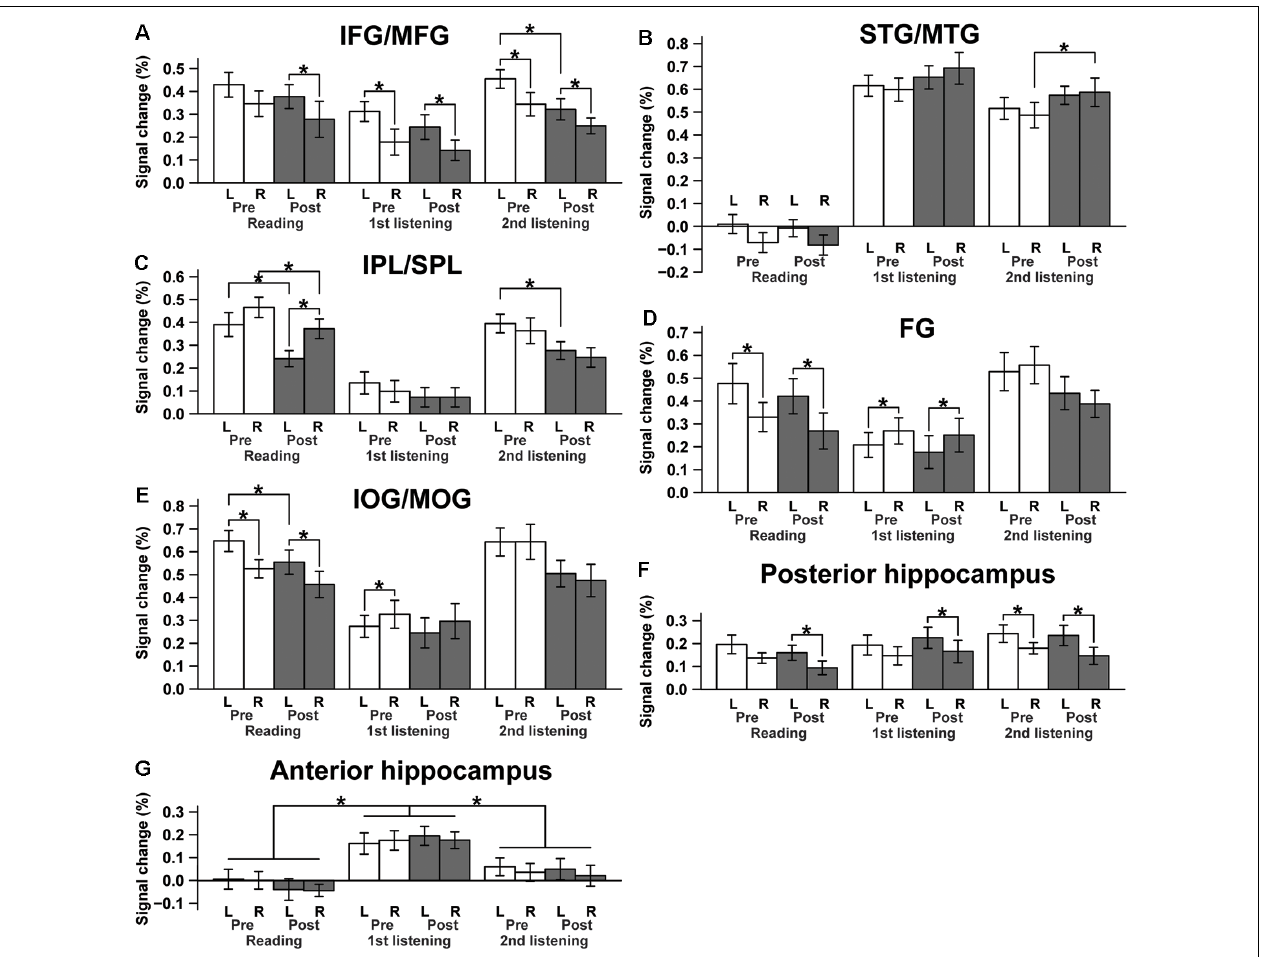
FIGURE 5 | Lateralization and changes in activations from Pre to Post for each ROI. (A) The IFG/MFG, (B) the STG/MTG, (C) the IPL/SPL, (D) the FG, (E) the IOG/MOG, (F) the posterior hippocampus, and (G) the anterior hippocampus. * p < 0.05 (paired t -test).